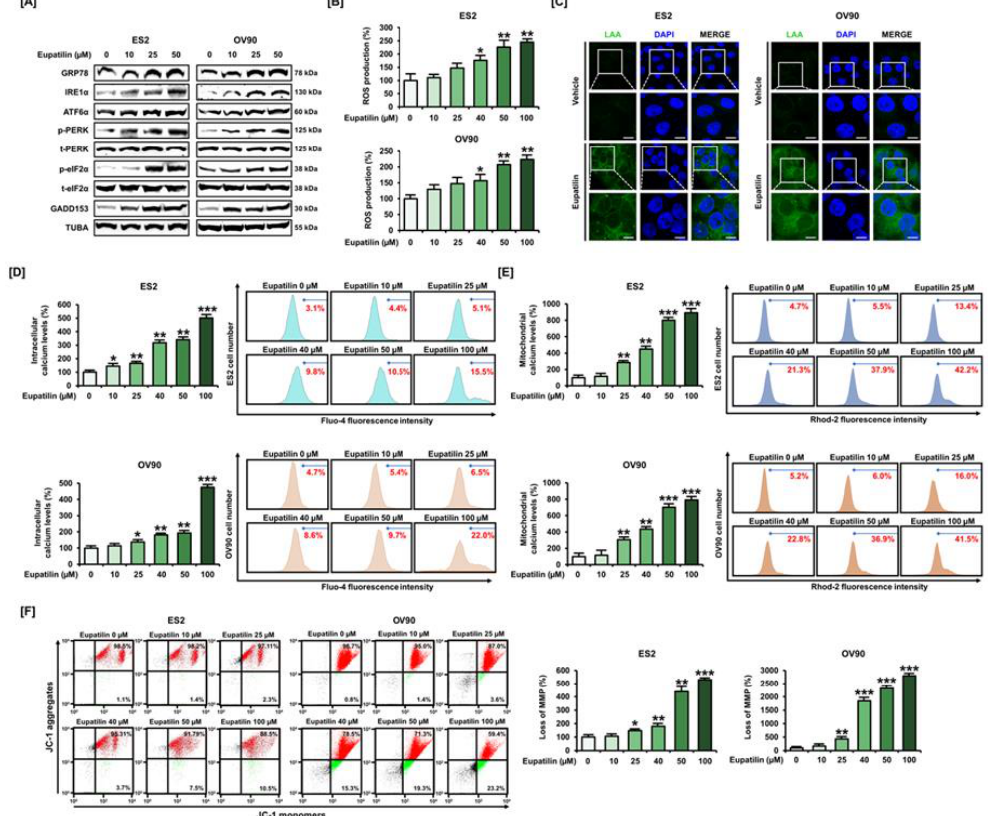
Figure 2. Effects of eupatilin on various aspects of cellular stress in ovarian cancer. ( A ) Western blot of endoplasmic reticulum (ER) stress regulatory proteins after ES2 and OV90 cells were treated with different concentrations of eupatilin. ( B ) The effects of eupatilin on reactive oxygen species (ROS) generation in ES2 and OV90 cells were evaluated by flow cytometry with dichlorofluorescin (DCF) fluorescence signals. ( C ) The effect of eupatilin on lipid peroxidation was determined by immunocytochemistry of linoleamide alkyne (LAA) to indicate lipid peroxidation with green fluorescence in the cytosolic fraction in ES2 and OV90 cells. The scale bar indicates 20 μm. ( D – E ) Eupatilin-mediated intracellular ( D ) and mitochondrial ( E ) calcium levels were investigated by flow cytometry with Fluo-4 and Rhod-2 fluorescence signals, respectively, after eupatilin treatment in ES2 and OV90 cells. ( F ) The mitochondrial membrane potential (MMP , ΔΨm) was analyzed by the distribution of red and green fluorescence using JC-1 staining after eupatilin treatment in ES2 and OV90 cells. The experiments were performed in triplicate. Data represent the mean ± standard deviation, and asterisks indicate that the effect of treatment was statistically significant (* p < 0.05, ** p < 0.01, and *** p < 0.001). Detailed information about the western blot can be found in Figure S1.